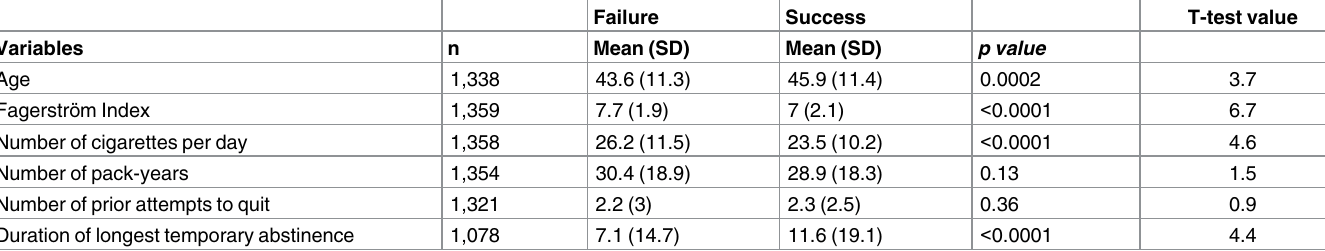
Table 2. Association between abstinence and each quantitative 1 variable at the initial